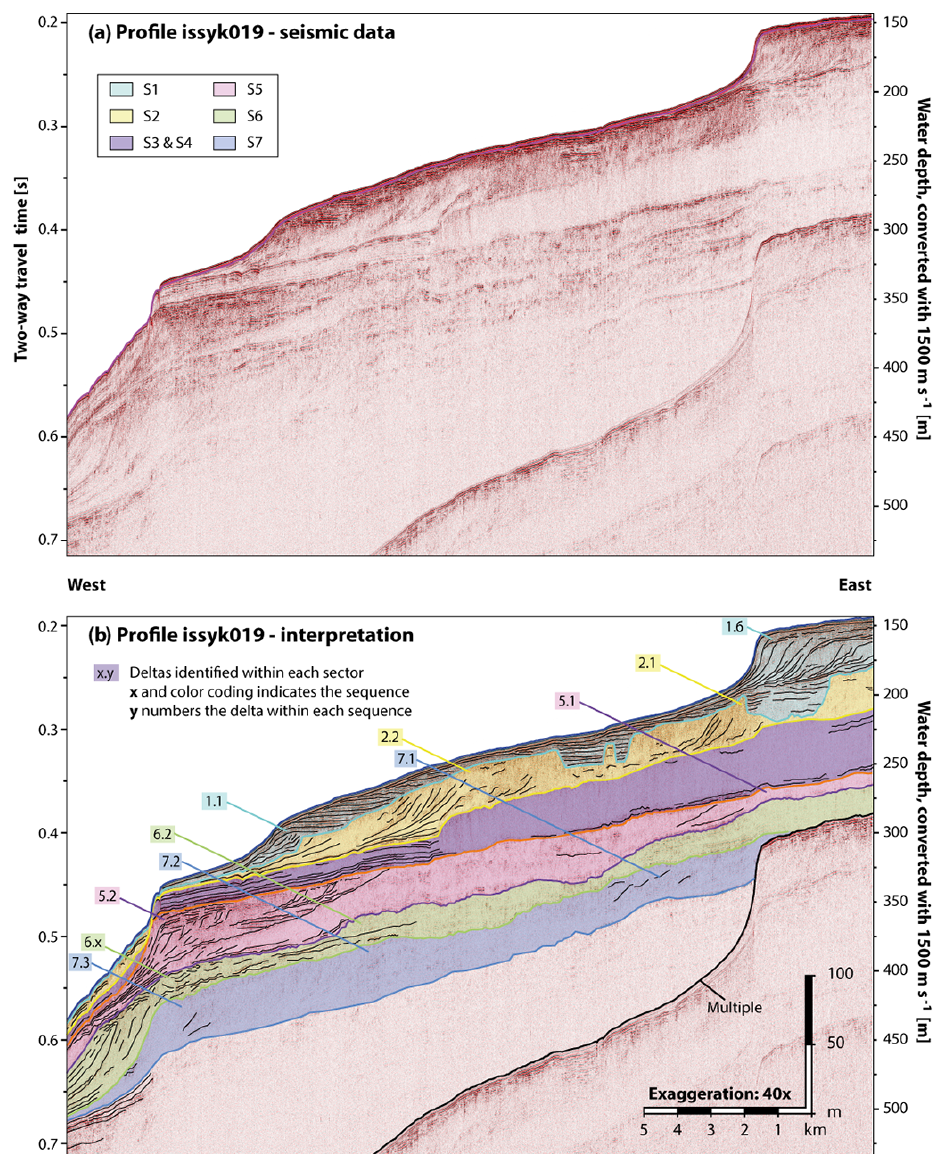
Figure 6. Seismic profile issyk019. Upper panel: seismic data. Lower panel: line drawing and interpretation of all sequences identified in the profile. All delta lobes identified in issyk019 are indicated. One delta lobe was spotted in S6 but could not be clearly identified because it is too eroded. This delta lobe is marked as 6 .x in the figure and was not considered for the reconstruction of the lake-level curve. See figure 1 for location of profile